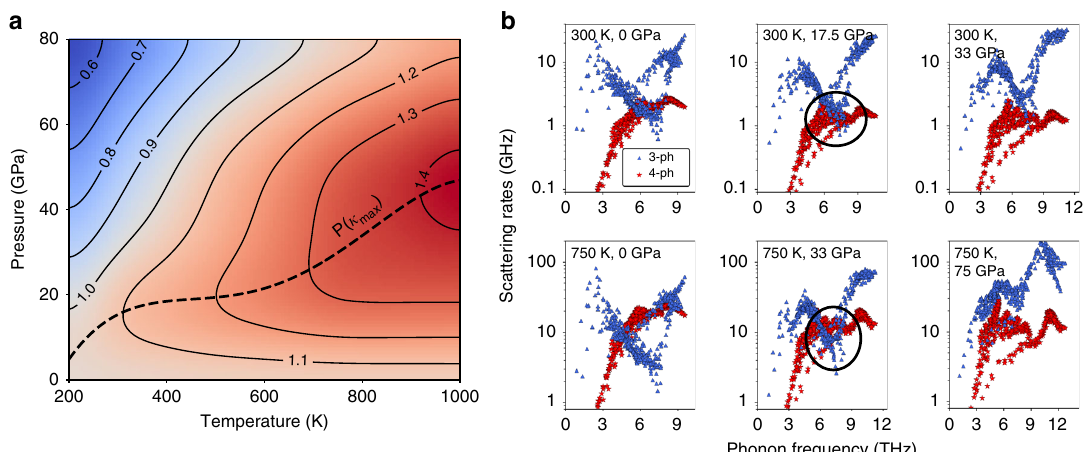
Fig. 4 Strengthening four-phonon scattering with temperature shifts the κ (3 + 4) -peak in BAs. a Pressure-temperature colormap of κ (3 + 4) scaled by the (cid:4) (cid:5) along with the iso- κ (3 + 4) / κ ð 3 þ 4 Þ corresponding zero-pressure value at each temperature κ ð 3 þ 4 Þ lines, showing the non-monotonic pressure dependence 0 0 of κ (3 + 4) at each temperature beyond 300 K. Also shown is the shifting position of the thermal conductivity peak on the pressure-temperature surface. b Comparison of three-phonon and four-phonon scattering rates of the acoustic modes in BAs at 300 K and 750 K at different pressures. The center plots [(300 K, 17.5 GPa) and (750 K, 33 GPa)] are the conditions close to the κ (3 + 4) -peak in Fig. 2c at the corresponding four-phonon scattering is delayed until higher pressures at higher temperatures, the κ (3 + 4) below the cross-over point keeps increasing with pressure rise. Thus, the percentage enhancement in κ (3 + 4) at the κ (3 + 4) -peak from the zero-pressure value is larger at elevated temperatures.